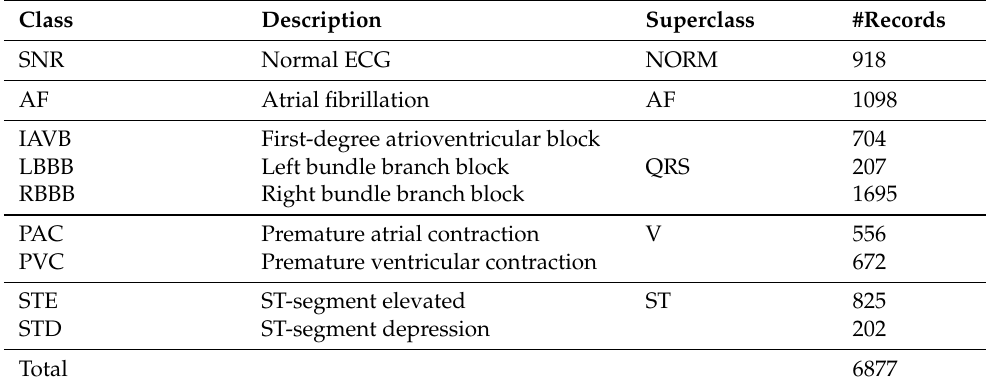
Table 1. ECG classes and their numbers in the CPSC2018 dataset.